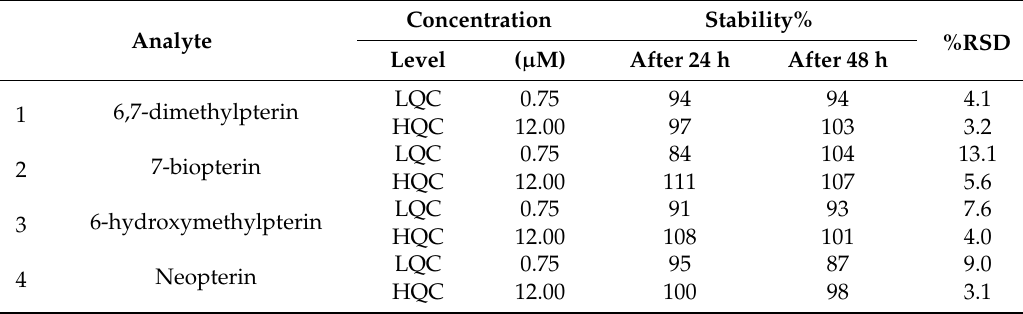
Table 4. Samples stability after freezing/thawing